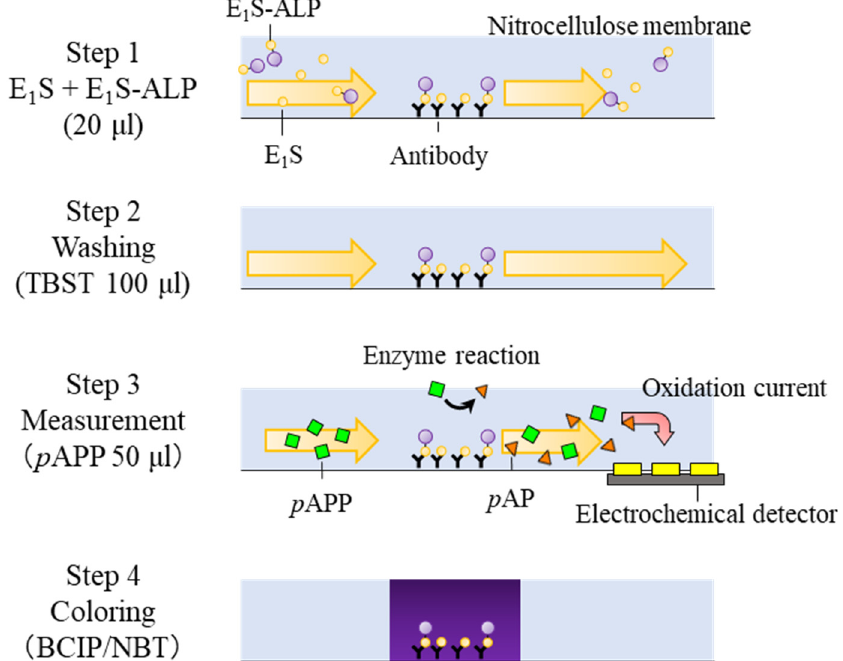
Figure 2. Measurement procedure of competitive immunoassay in the electrochemical immunochroma tography. Firstly, 10 µ L of E 1 S solution and 10 µ L of E 1 S-ALP solution (50 ng / mL of E 1 S-ALP in 20 mM tris buffered saline containing 0.05% Tween20 (TBST) containing 0.1% bovine serum albumin (BSA)) were added to the inlet of the electrochemical immunochromatography platform. E 1 S and E 1 S labeled with alkaline phosphatase (E 1 S-ALP) competed with each other and were captured by the immobilized anti-E 1 S antibody. Secondly, 50 µ L of 20 mM TBST was added twice to flush out the untrapped E 1 S and E 1 S-ALP. Thirdly, 50 µ